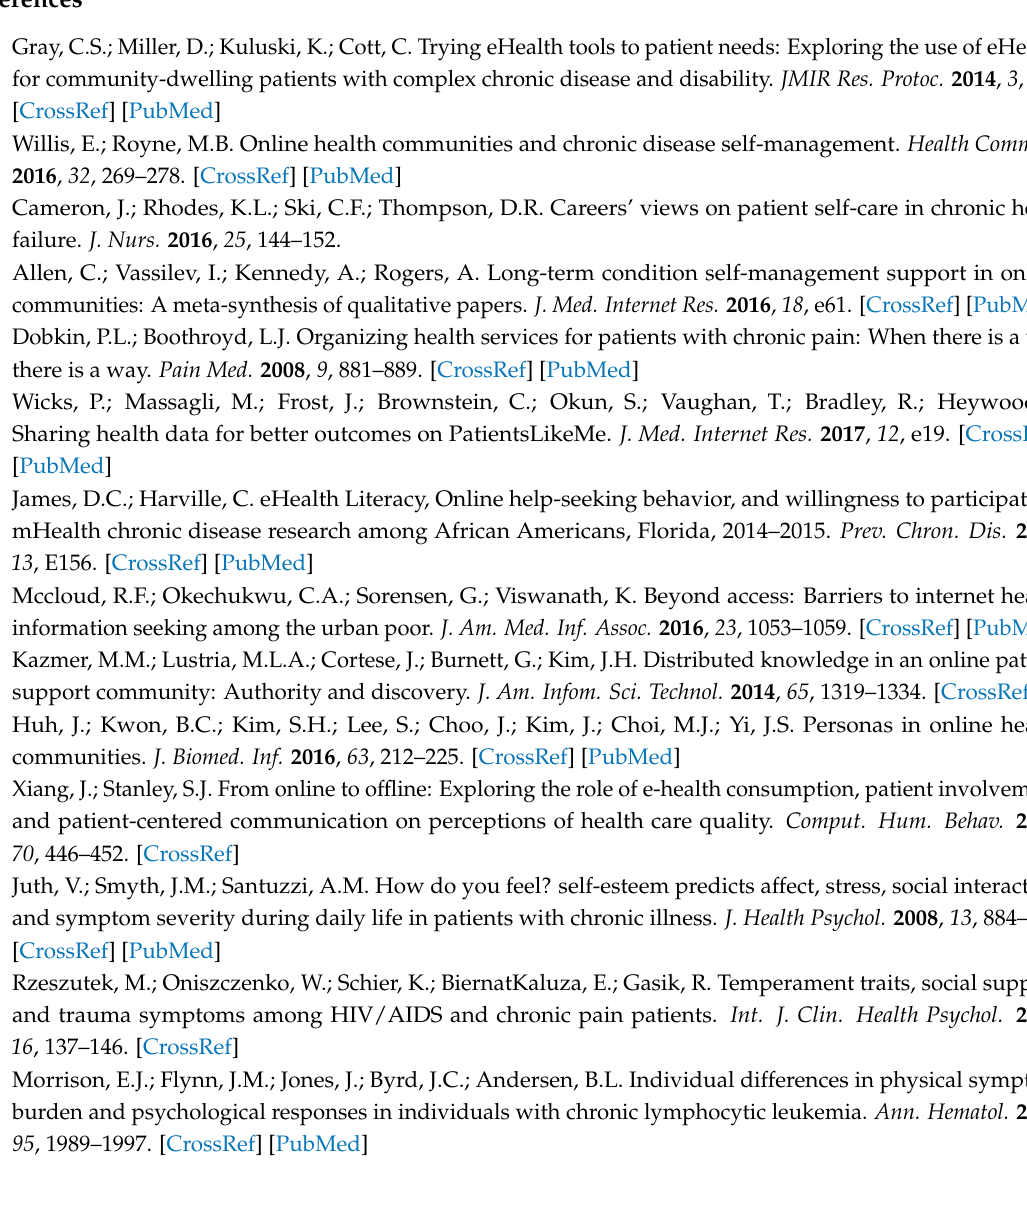
Table S1: One-hundred health-related websites in our descriptive study; Evaluation instrument 3: Influence of domain knowledge on social network in